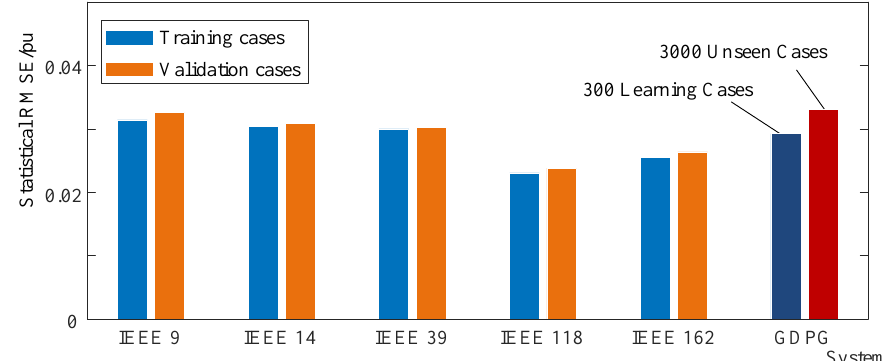
Figure 4. Statistics of TS reconstruction errors in different systems.